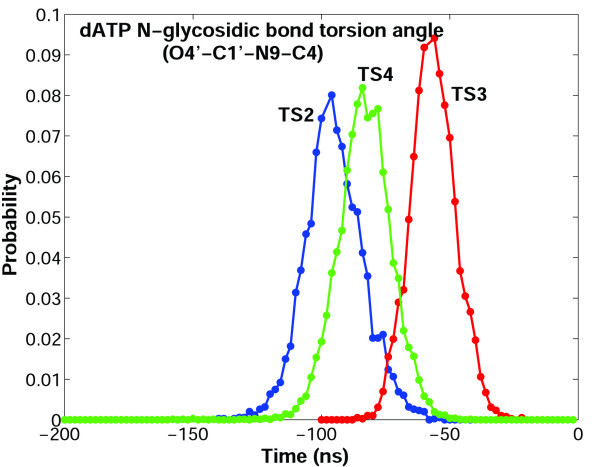
Conformation of dATP in the 8-oxoG:dATP complex. The probability distributions of the N-glycosidic bond torsion angle of dATP during transition states 2 (Asp192 flip, blue), 3 (Arg258 rotation, red), and 4 (Phe272 flip, green) in the 8-oxoG:dATP complex.